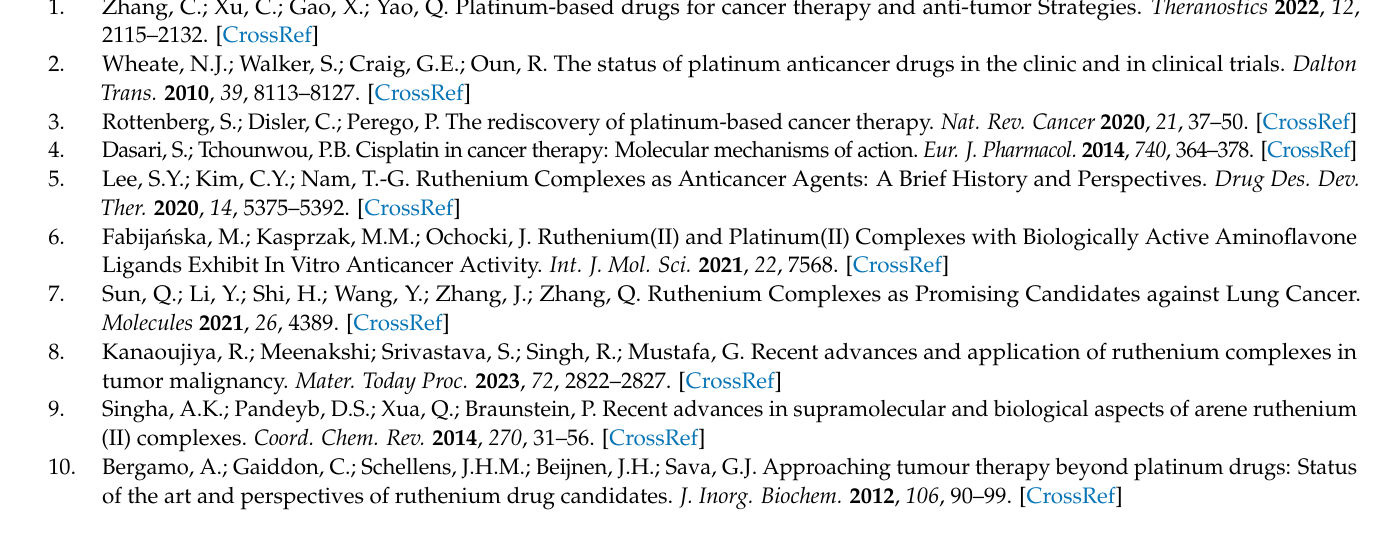
Figure S3: Structure of [RuNOTSP]+ cation; Table S1: Summary of Natural Population Analysis (NPA) of TSPH; Table S2: Coordinates parameters for TSPH 2 ; Table S3: Summary of Natural Population Analysis (NPA) for TSP 2 − anion; Table S4: Coordinates parameters for TSP 2 − anion; Table S5: Summary of Natural Population Analysis (NPA) of [RuNOTSP] + ; Table S6: Coordinates parameters for [RuNOTSP] +